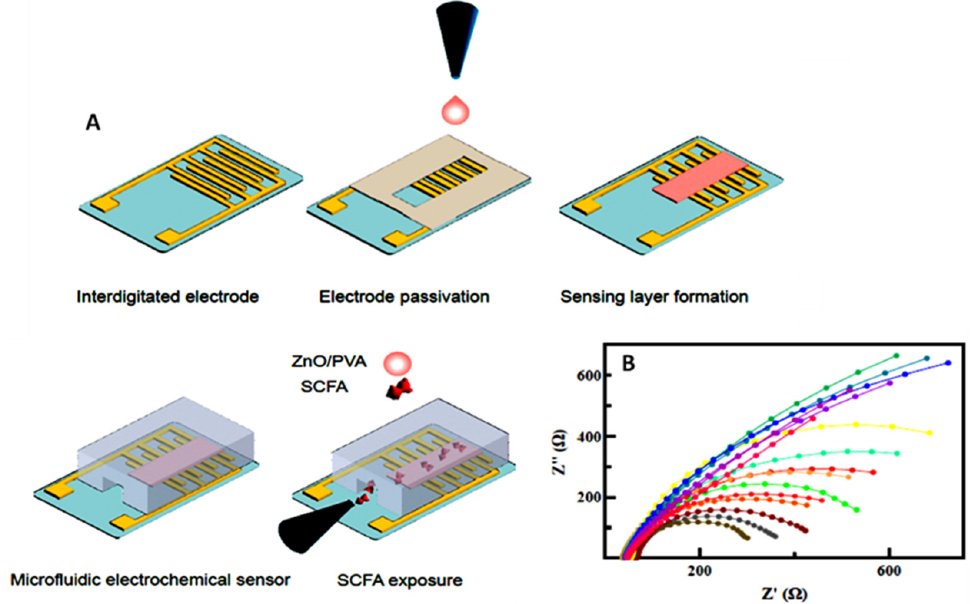
Figure 3. ( A ) Schematic view of the microfluidic setup and sensing layer synthesis for the determi- nation of SCFAs and ( B ) Nyquist spectra of the sensing layer at various concentrations of acetic acid and propionic acid in a mixture with 0.5 mg mL − 1 butyric acid. Adapted from [35] with permission.